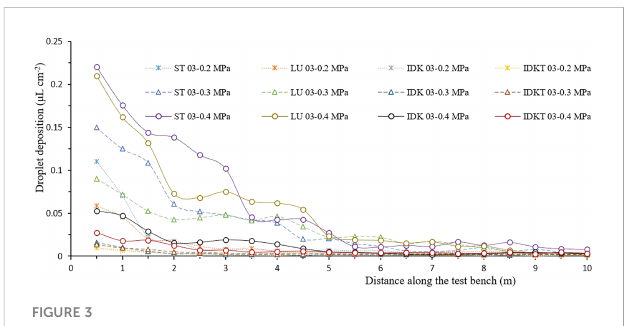
FIGURE 3 Spray deposit pro fi les of different ISO 03 nozzle-pressure combinations along the test